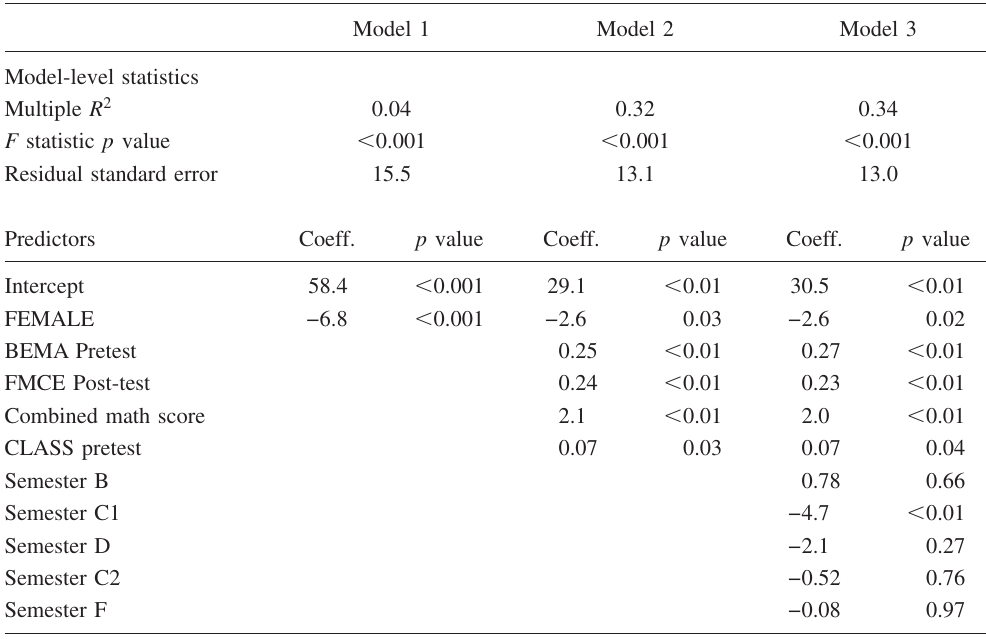
TABLE XI. Coefficient estimates and multiple-regression model statistics for each multiple-regression model. The S 1 sample was used for this regression